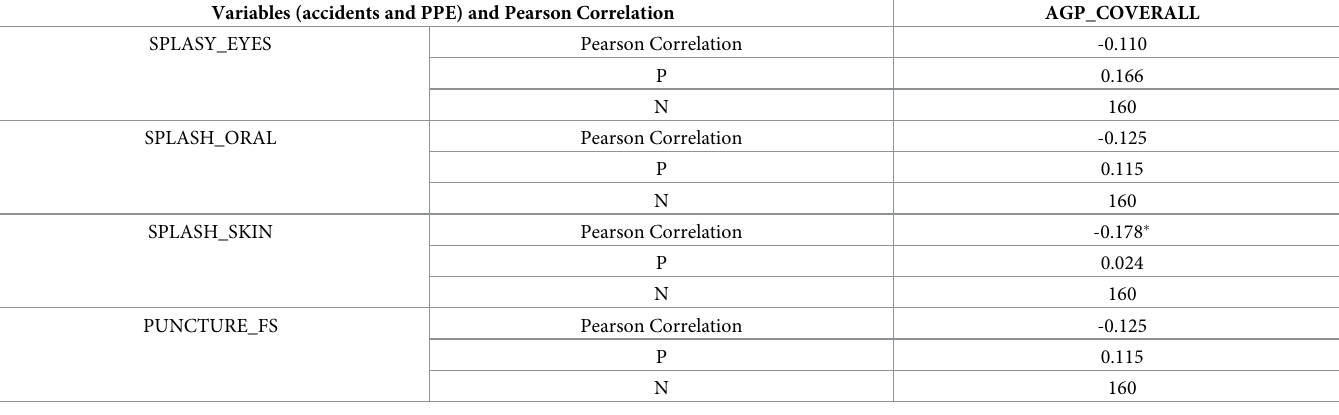
Table 5. Correlation coefficients and associated level of significance. Testing hypothesis